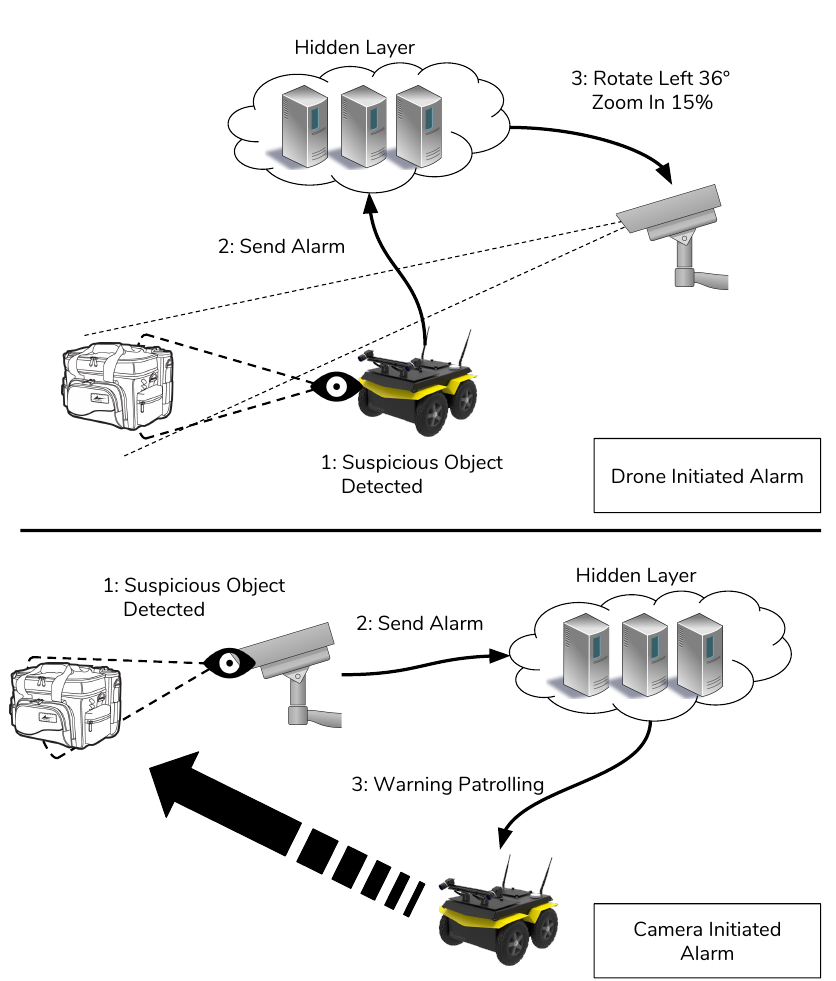
Figure 3. Hidden layer coordination